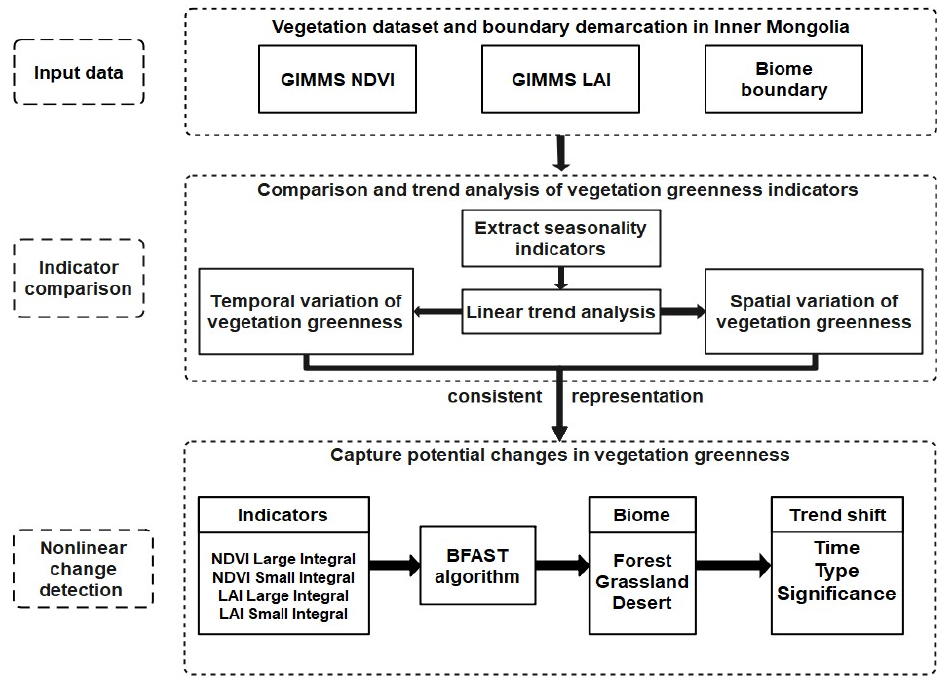
Figure 2. Flowchart showing the detailed steps in detecting vegetation greening over Inner Mon- golia.